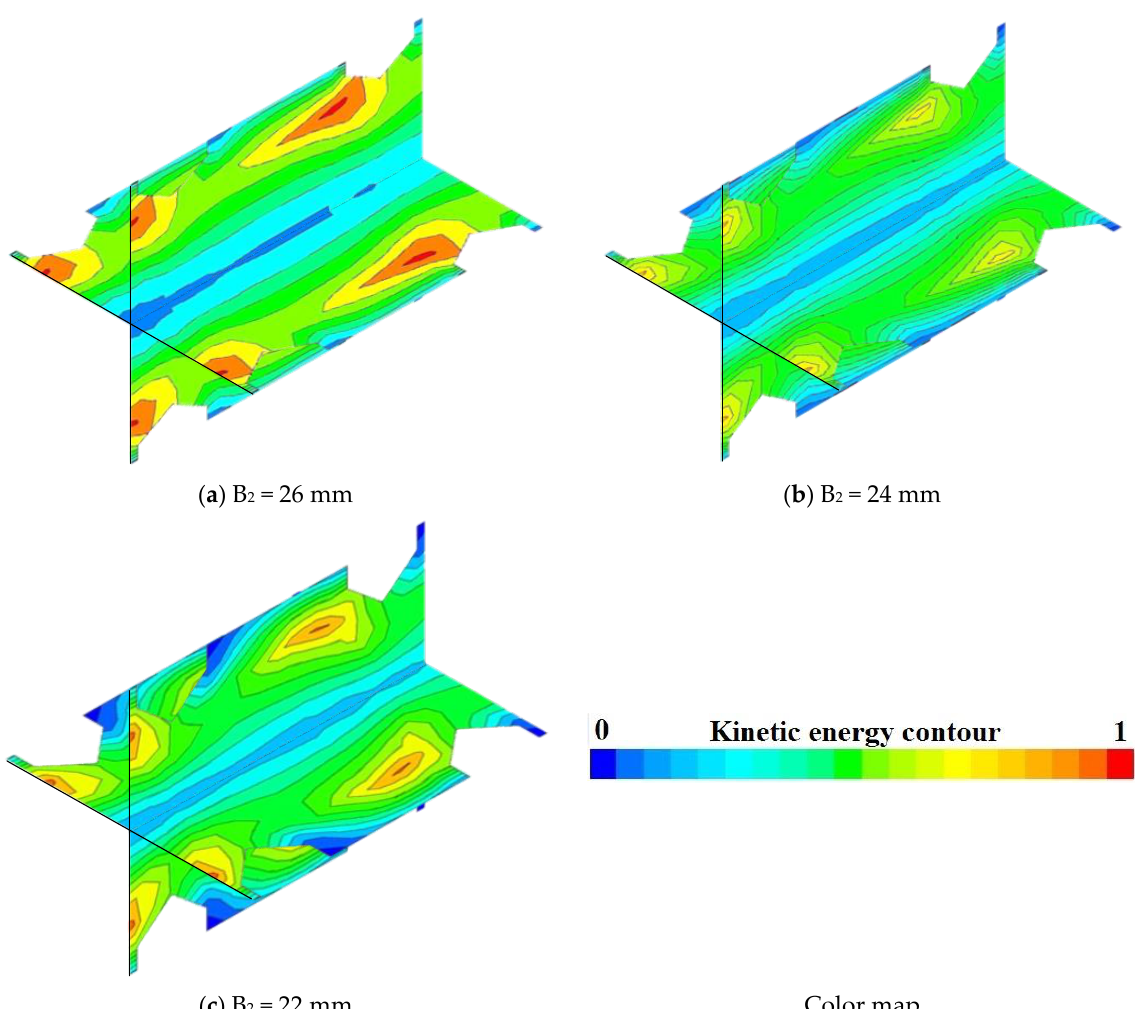
Figure 17. Temperature contours for various configurations of Case B with different B 2 parameters at R = 15 mm, Re = 15,000, and ϕ = 0.5%.